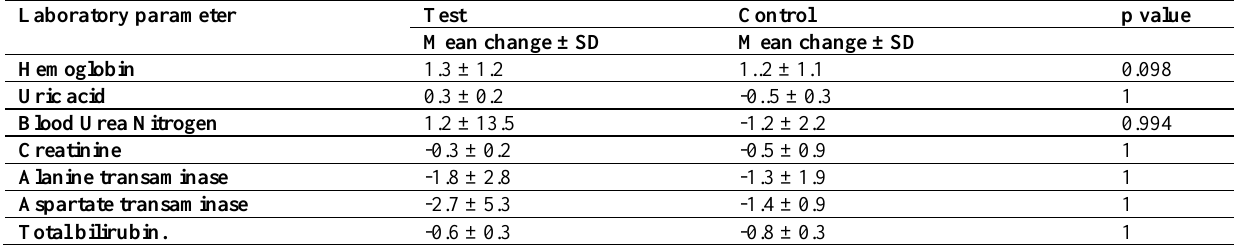
Table 4: Comparing the change in laboratory parameters between the two